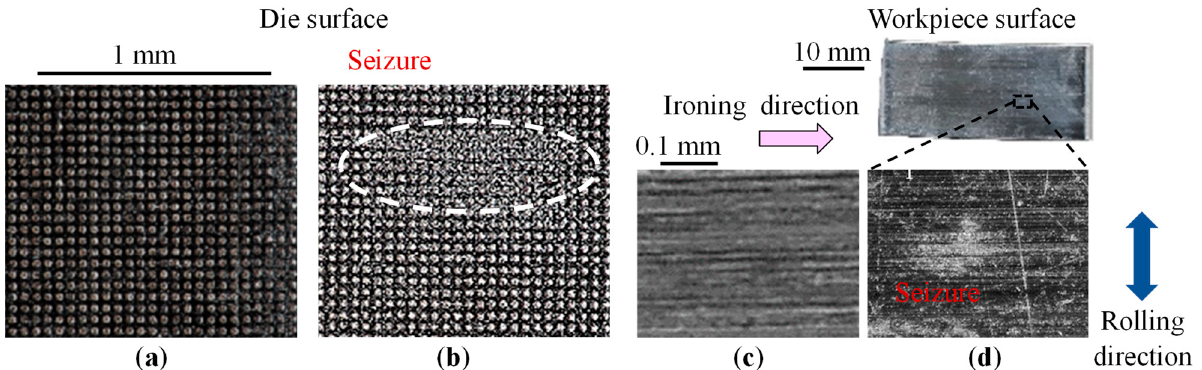
Figure 9. Optical micrograph of the die and workpiece surfaces after ironing with grid array pattern, d = 30 µm, h = 2 µm and L = 50 µm: ( a ) die surface without seizure at r = 15%; ( b ) seizure on die surface at r = 18%; ( c ) workpiece surface without seizure at r = 15%; and ( d ) seizure on workpiece surface at r = 18%.